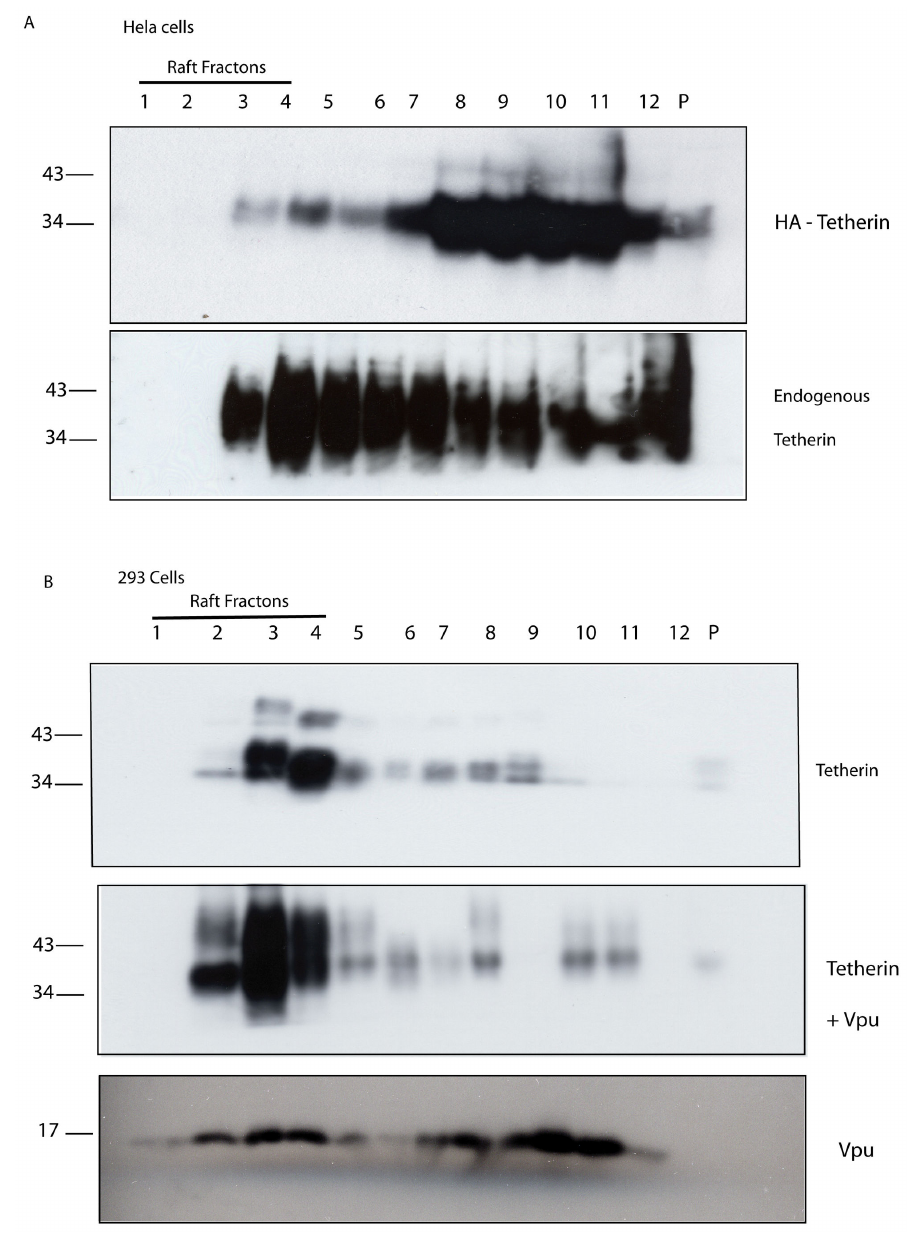
Figure 2. Variation in the degree of localization of tetherin to lipid rafts. Cells were subjected to extraction in ice-cold Triton X-100 (1%) prior to separation by sucrose density gradient centrifugation, then analysis of fractions from the gradients by immunoblot. Fractions 1-4 are considered as the lipid raft fraction, fractions 5-12 as non-raft fractions. A. The top panel shows an immunoblot, using an antibody to the HA epitope tag on recombinant HA-tagged tetherin expressed in HeLa cells, of fractions from HeLa cells transfected to express HA-tagged tetherin and shows that the majority of recombinant HA-tagged tetherin is not present in lipid rafts (i.e. it is in fractions 5-12). The second panel shows an immunoblot, using an antibody to tetherin, of fractions from HeLa cells and shows that a significant proportion of endogenous tetherin is present in lipid rafts (i.e. in fractions 1-4). B. The first panel shows an immunoblot, using an antibody to the HA epitope tag on recombinant HA-tagged tetherin expressed in HEK293T cells (NB HEK293T cells do not express detectable levels of endogenous tetherin), of fractions from HEK293T cells transfected to express HA-tagged tetherin and shows that the majority of recombinant tetherin is present in lipid rafts (i.e. in fractions 1-4). The second panel shows the same, but in HEK293T cells that express Vpu-GFP in addition to HA-tagged tetherin: this experiment was performed in the absence of lysosomal enzyme inhibitors, the blot was exposed longer to ensure detection of tetherin. The bottom panel shows the distribution of Vpu-GFP expressed in the same cells; it is present in both raft and non-raft fractions. doi: 10.1371/journal.pone.0075680.g002 PLOS ONE |